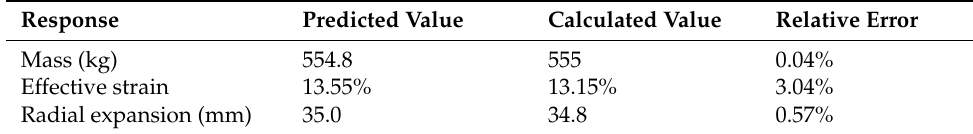
Table 5. The error between the surrogate model and numerical simulation.